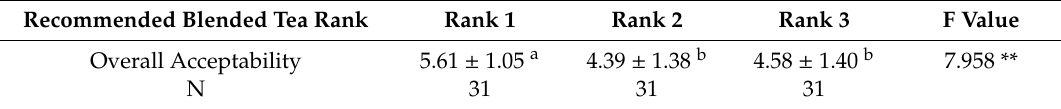
Table 7. Di ff erences of overall acceptability by recommendation